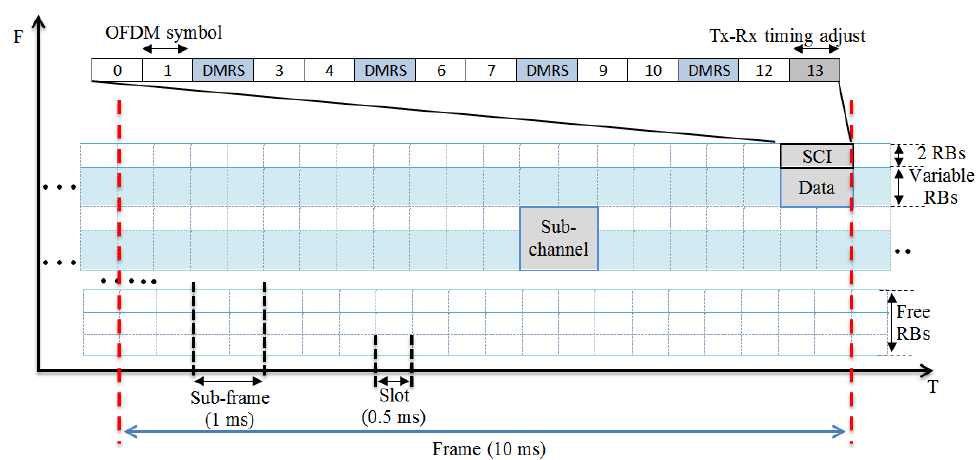
Figure 1. C-V2X resource grid description in time and frequency